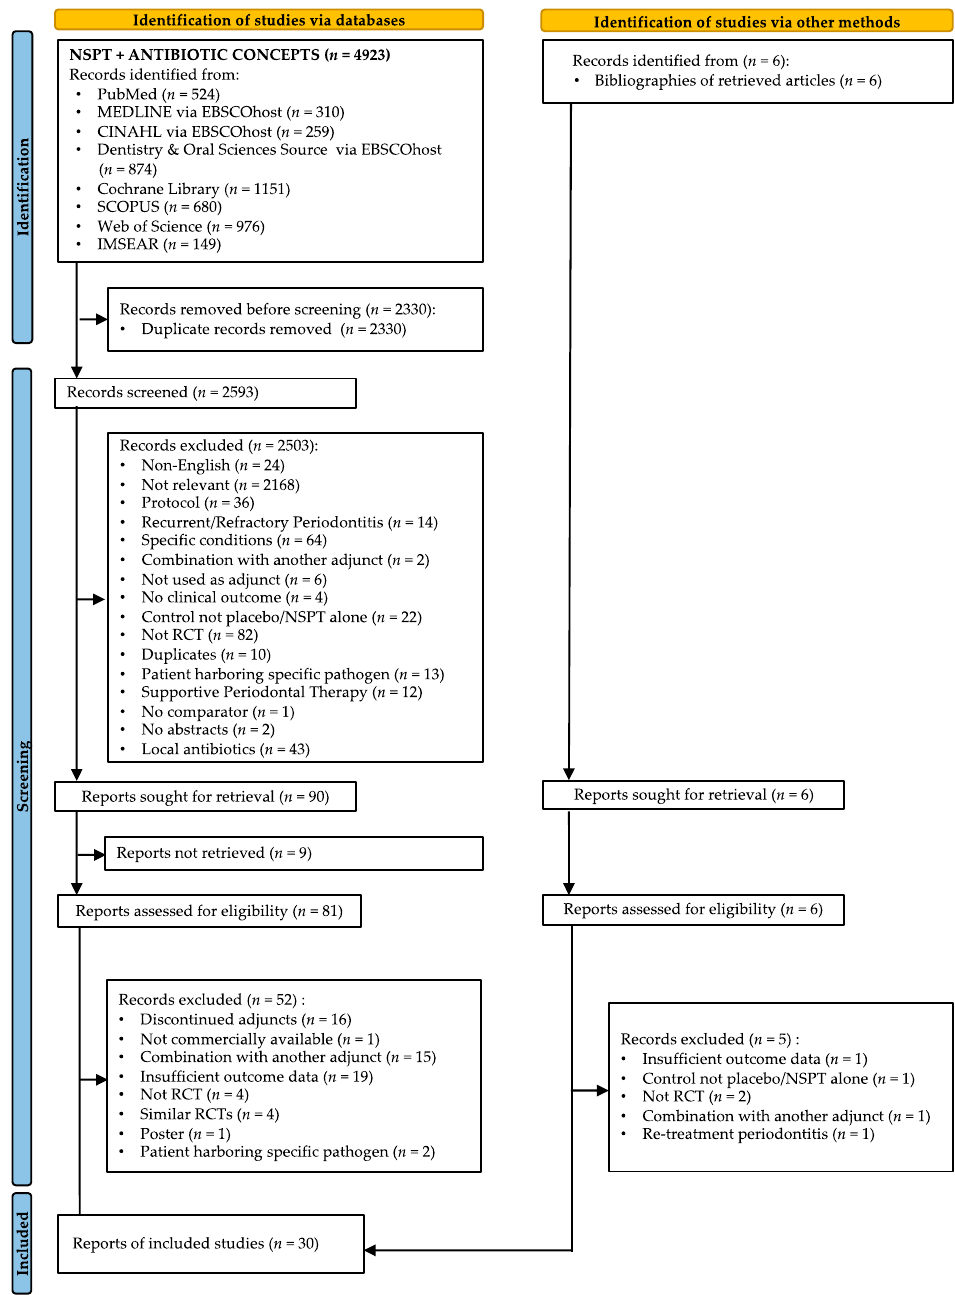
Figure 1. Preferred reporting items for systematic reviews and meta-analyses (PRISMA) flow diagram of the study-selection process.